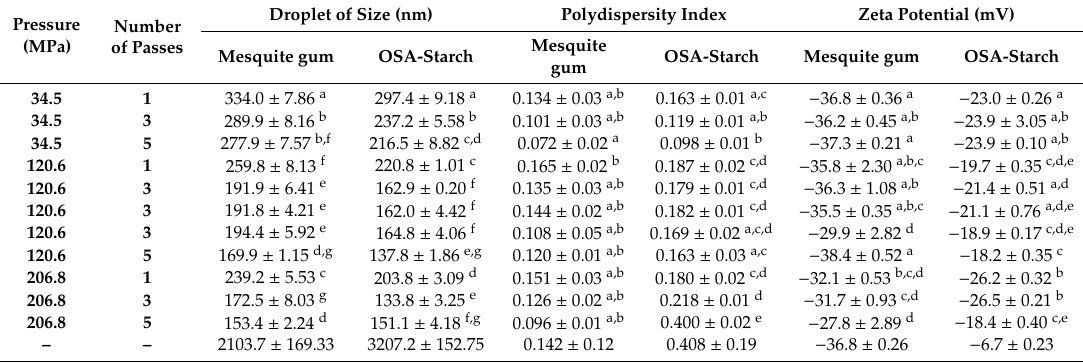
Table 1. The droplet of size, polydispersity index, and zeta potential for mesquite gum and OSA-starch emulsions according to the factorial